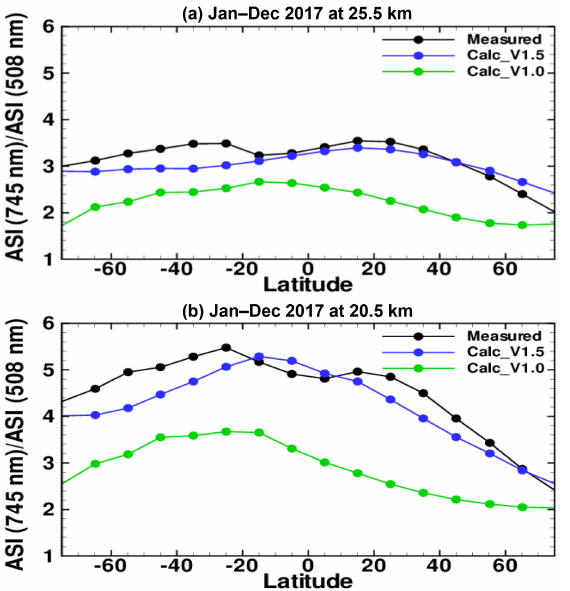
Figure 8. Zonal mean of ratio ASI(745nm) / ASI(508nm) at 25.5km (a) and 20.5km (b) as a function of latitude. Calculated values using the V1.5 ASD (blue dots) are more effective in ex- plaining the measured ASI ratios (black dots) than the V1.0 ASD (green dots).